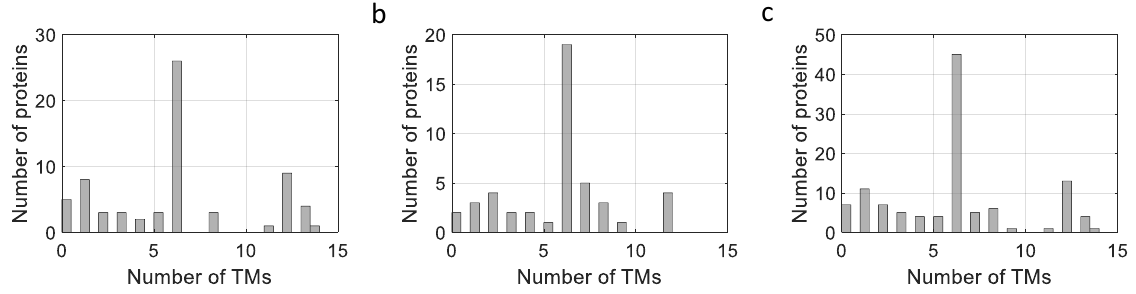
Figure 4. Influence of number of TM helices on expression of MPs expressed in L. lactis . ( a ) On expression of MPs from L. lactis . ( b ) On expression of MPs from other bacteria. ( c ) On expression of eukaryotic MPs.